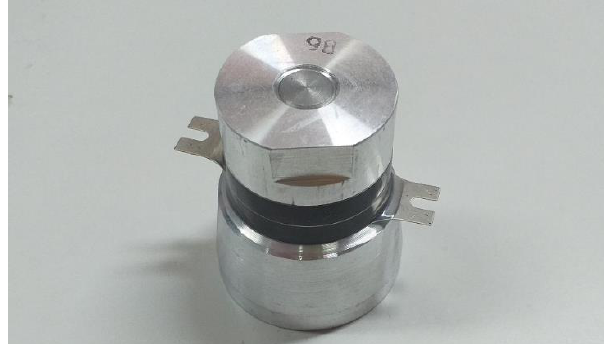
Figure 1. The photo of a piezoelectric ceramic actuator.